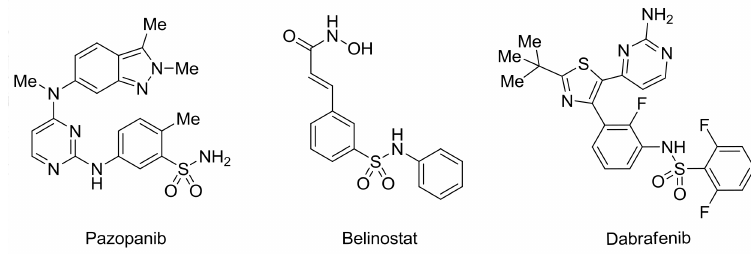
Figure 2. Sulfonamides used as antitumor